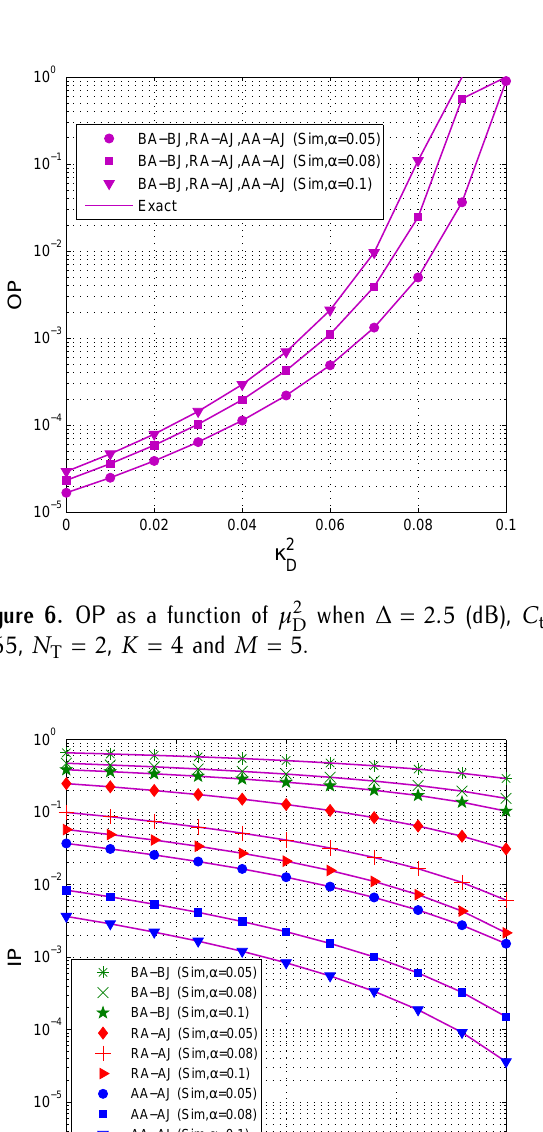
when ∆ = 2 . 5 (dB), C E